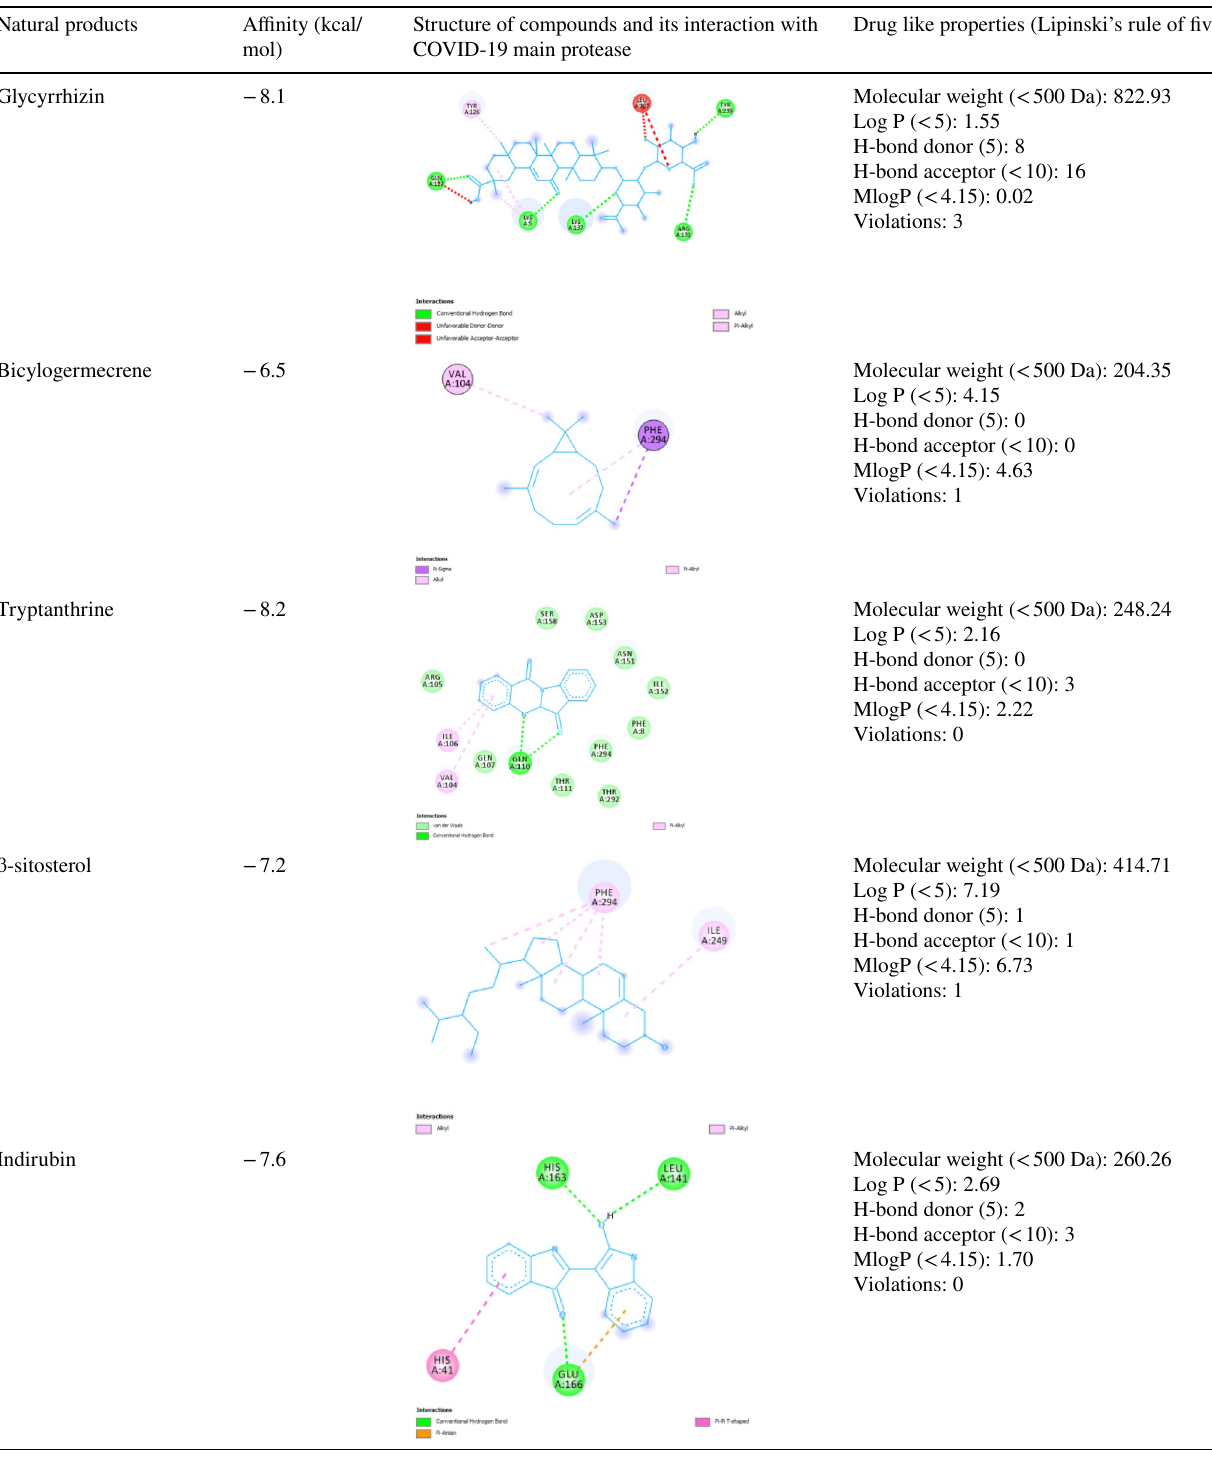
Table 1 Docking results of natural products in terms of binding affinity (kcal/mol), interaction of natural products with the COVID-19 main pro- tease (PDB ID: 6LU7) and the drug like